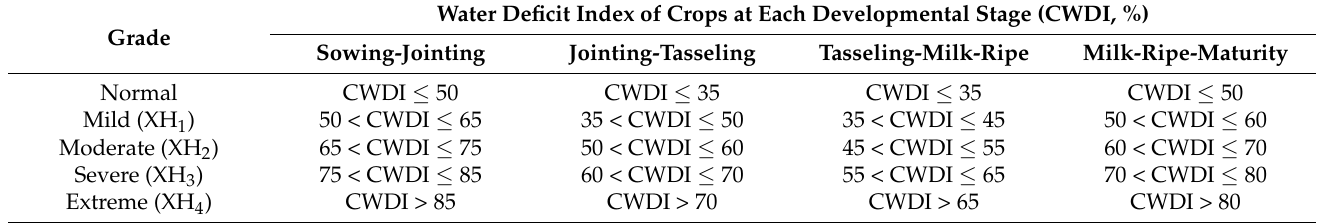
Table 2. Grades of maize drought in different periods based on crop water deficit index